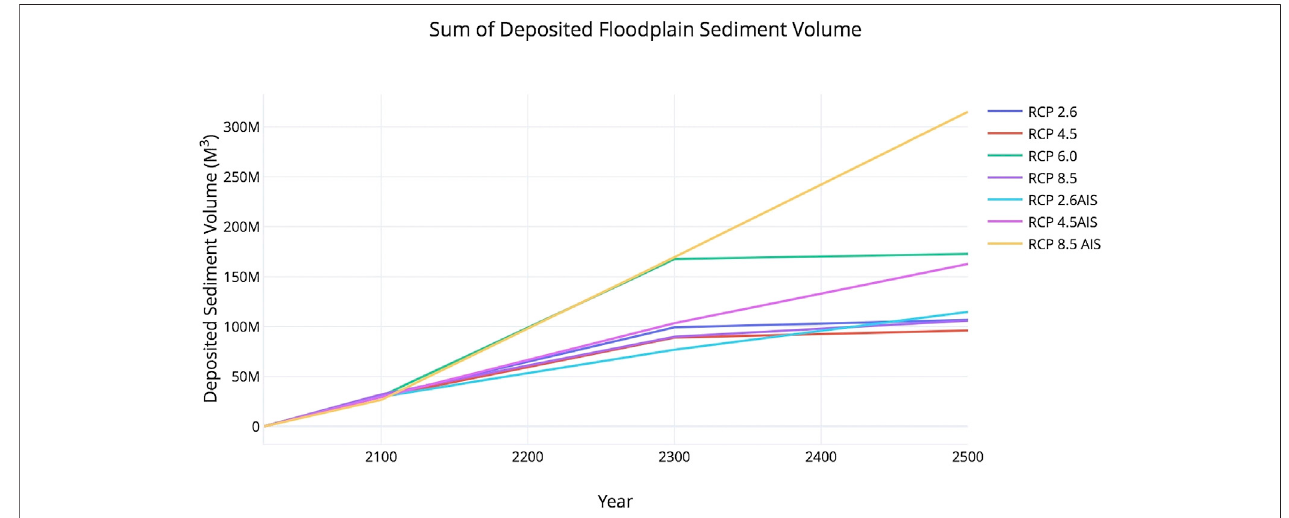
FIGURE 14 | Comparison of the sum volume of deposited sediment within the fl oodplain under all scenarios (not including precipitation scenarios).